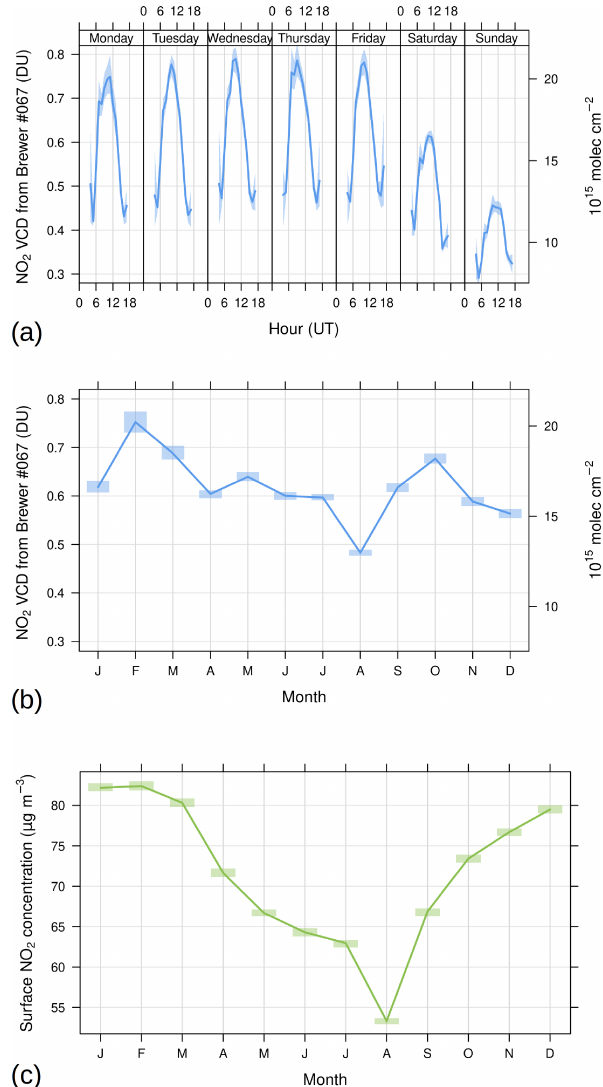
Figure 4. Daily, weekly (a) , and monthly (b) cycles of NO 2 VCDs from Brewer #067 (averages from period 1996–2017), and monthly cycle of NO 2 surface concentrations (averages from period 1999– 2017) measured by the local environment protection agency at the Magna Grecia station (c) 2.6km away from